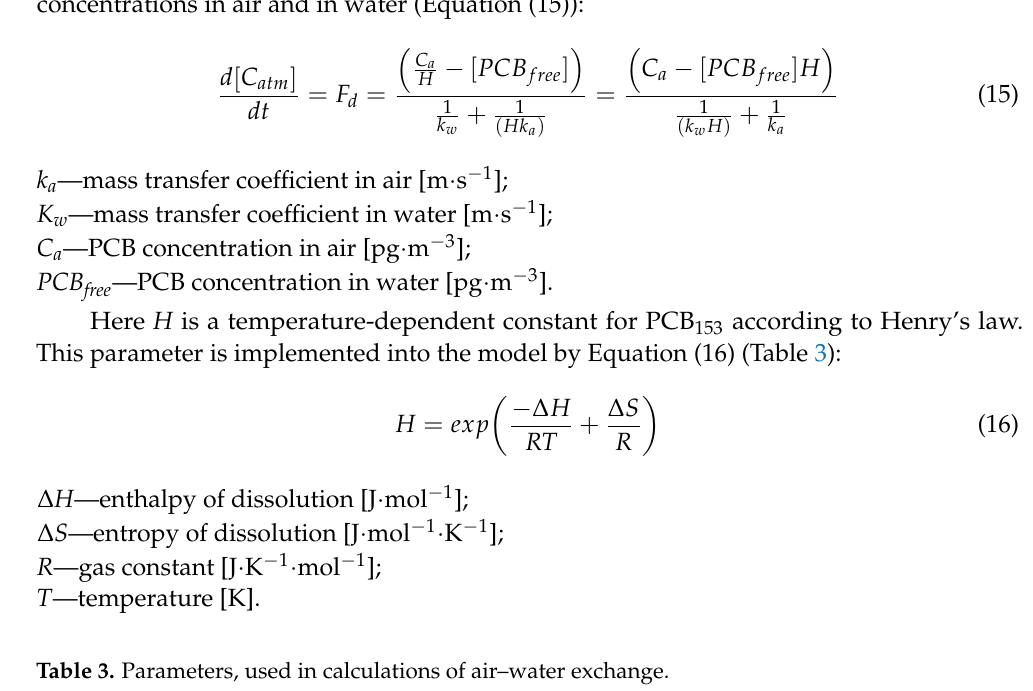
Calculated Calculated